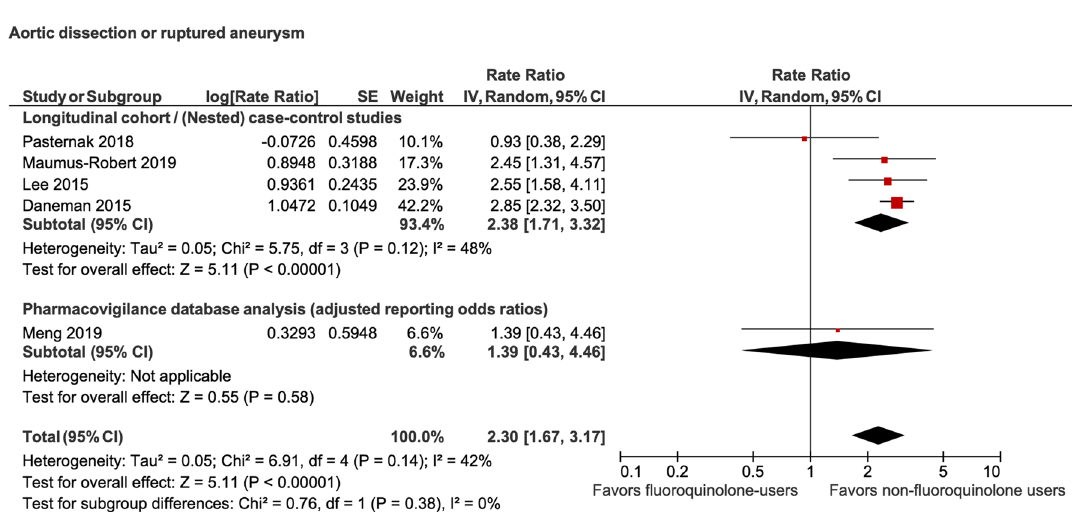
Figure 2. Association between fluoroquinolone use and aortic